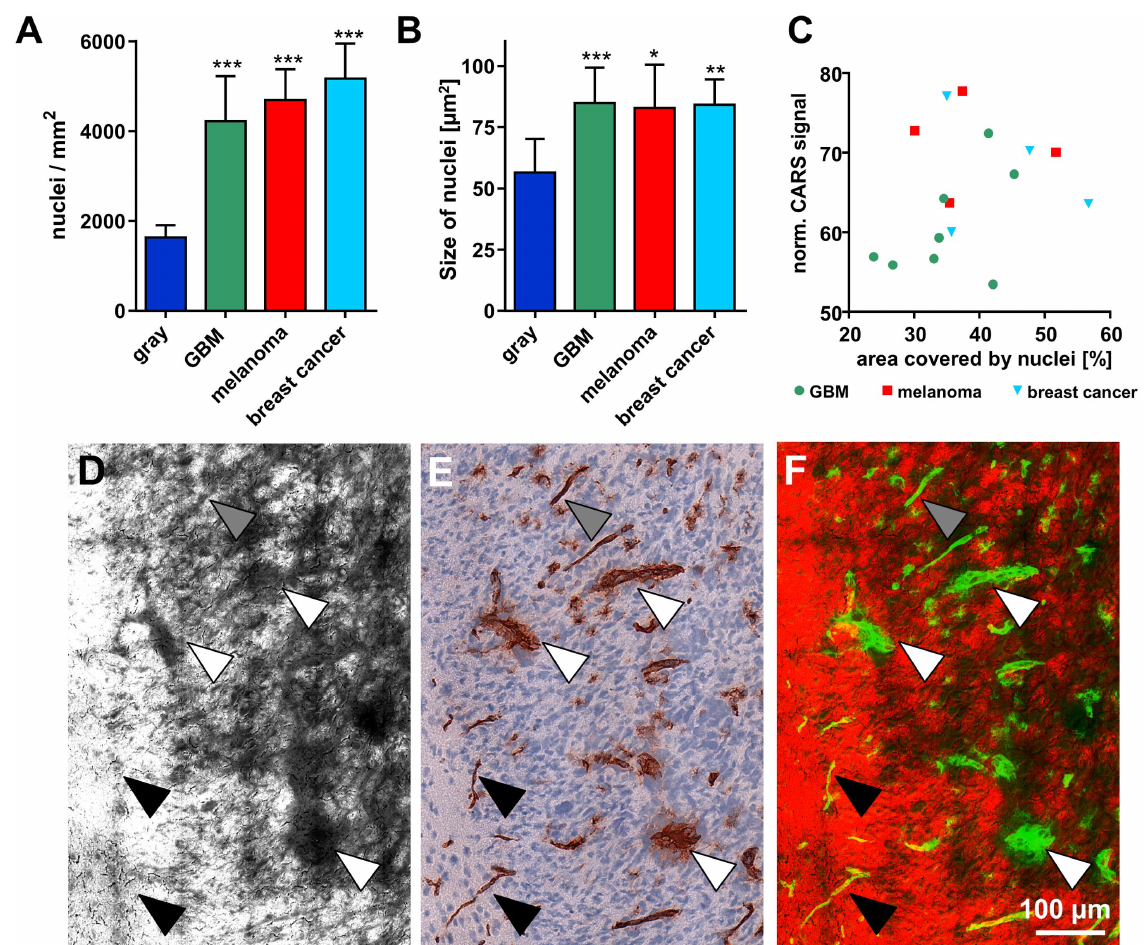
Figure 5. Tumor-induced changes influence the CARS signal intensity. A/B : Number of nuclei/mm 2 representing cellular density (A) and size of single nuclei (B) within normal gray matter and different experimental tumors in a mouse brain. Bars represent mean 6 SD, GBM n=8; melanoma metastases n=4; breast cancer metastases n=4; *** significant difference vs. normal gray matter: P , 0.001. C : Dot plot showing the total area occupied by cell nuclei vs. the normalized CARS signal intensity of the respective tumor. D : CARS image of an experimental GBM induced in a mouse brain. E : Anti-CD31 staining of a consecutive section of the one shown in D. F : Overlay of CARS (red) and anti-CD31 (in false color: green). Coarse blood vessels (white arrowheads) and fine blood vessels (gray arrowheads) are detected in the CARS image. Very fine (normal) blood vessels do not cause any alterations of the CARS signal (black arrowheads).